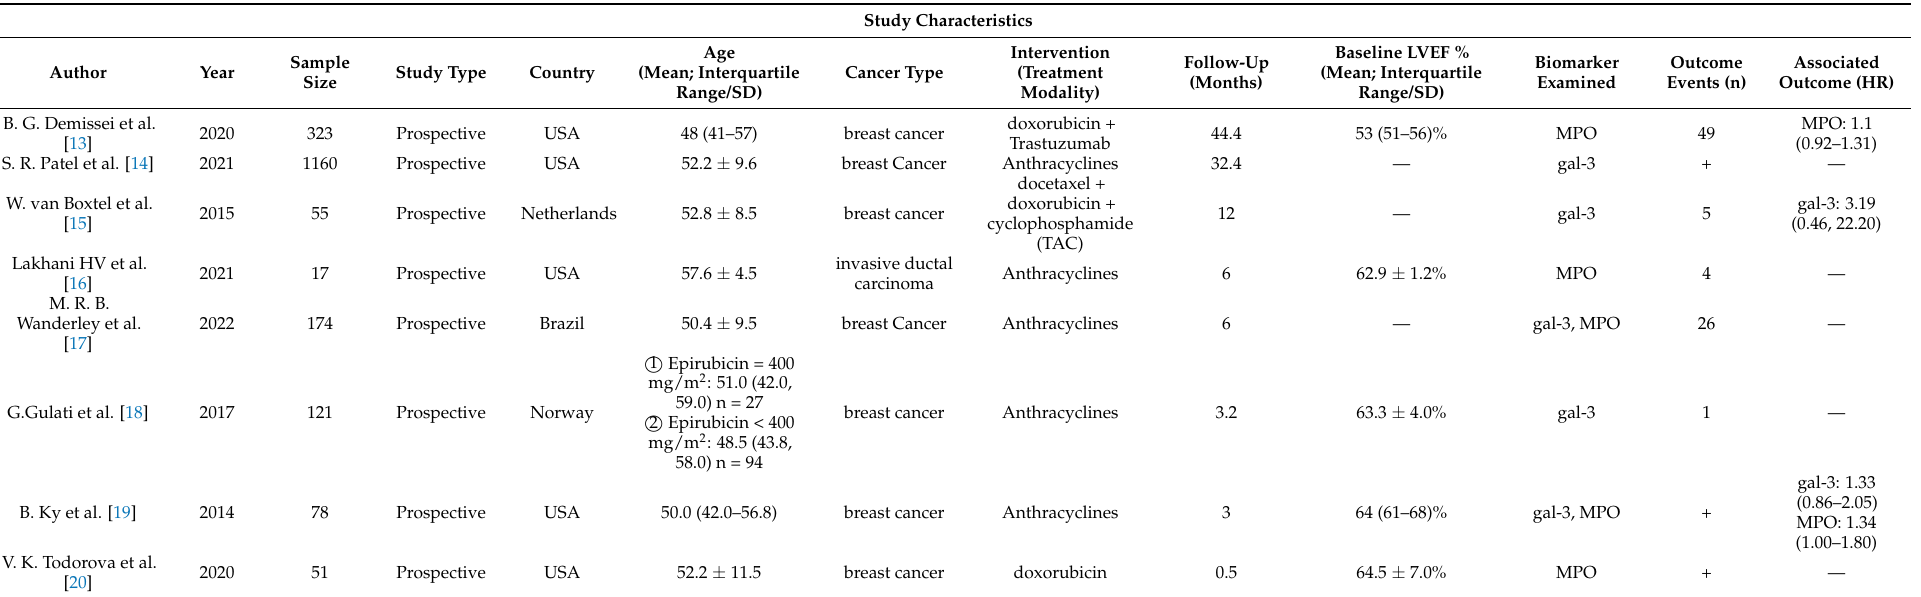
Table 1. Study Characteristics. Values are expressed as mean ± SD or median [interquartile range] for continuous variables. LVEF: Left Ventricular Ejection Fraction; gal-3: galectin-3; MPO: myeloperoxidase. +: The main outcome event occurred, but the number of events was not extracted; —: No accurate data were extracted. 1 (cid:13) 2 (cid:13) : Age distribution of different